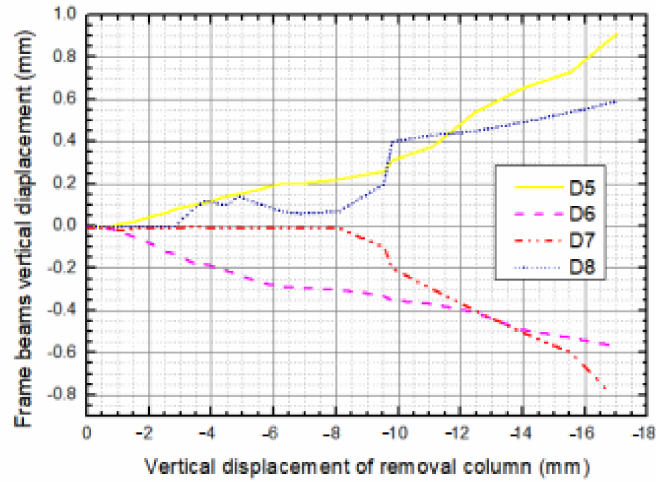
Figure 10. The vertical displacement of the IAP components.